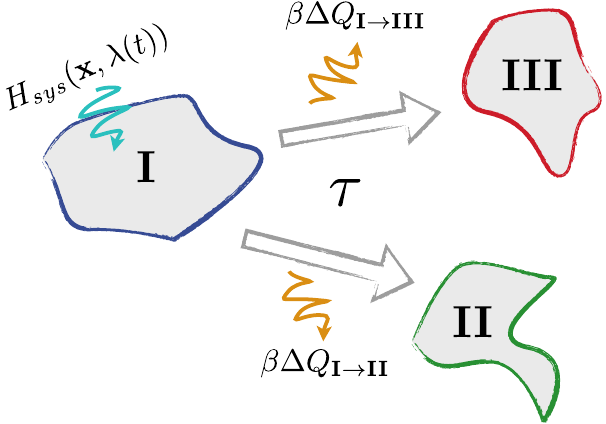
FIG. 3. In this scenario, we consider a starting nonequilibrium macrostate I that is driven by an external field while it evolves stochastically in contact with a thermal bath. We may ask whether, after some finite time τ , it is more likely to be found in one of two other possible macrostates II and III . The relative likelihood of these two different possibilities will be determined in part by the statistical distributions for possible values of the external entropy production β Δ Q I → in each (cid:3)